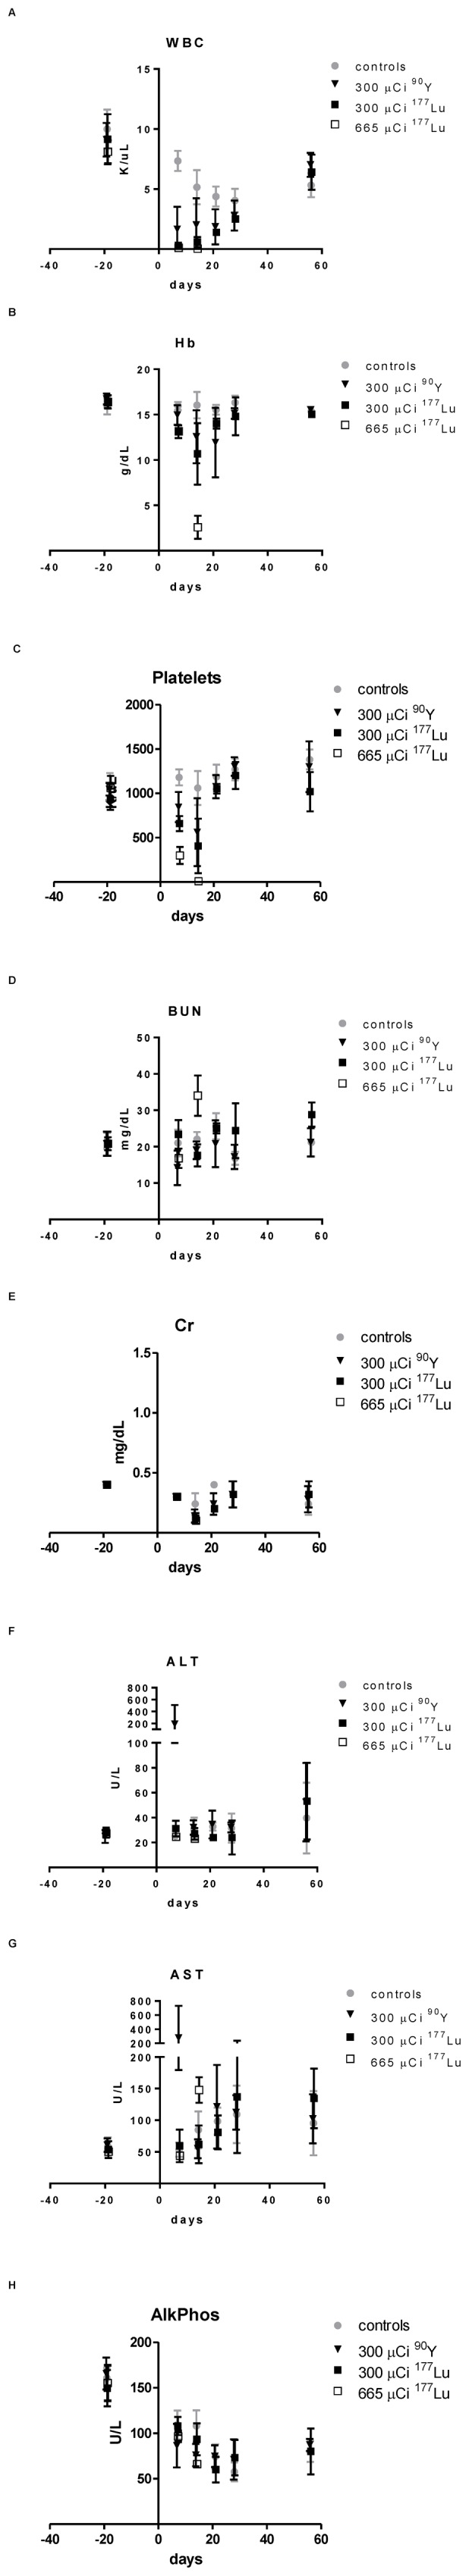
Hematologic, renal and hepatic toxicity.Five mice per group were bled at baseline (day -19), 1, 2, 3, 4, and 8 weeks after injection of radiolabeled anti-CD45 Ab at time 0 [300 µCi 90Y-DOTA-30F11 (▾), 300 µCi 177Lu-DOTA-30F11 (▪), or liver 90Y-DOTA-30F11 equivalent dose of 665 µCi 177Lu-DOTA-30F11 (□)]. Blood was analyzed for A) WBC, B) Hg, C) platelets, D) BUN concentrations, E) Cr, F) AST, G) ALT, and H) ALP, and values were compared to values from age-matched untreated control mice ().